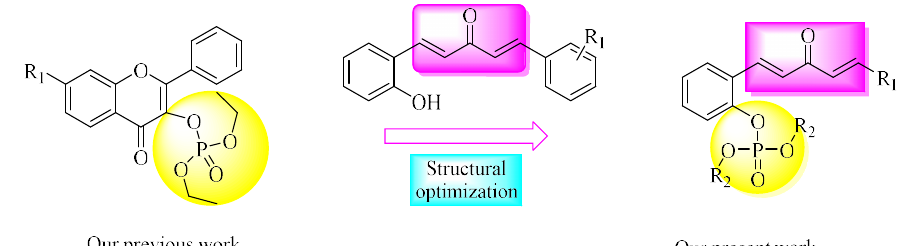
Figure 1. The structures of penta-1,4-dien-3-one and some commercial drugs. Figure 2. Design of the title compounds.